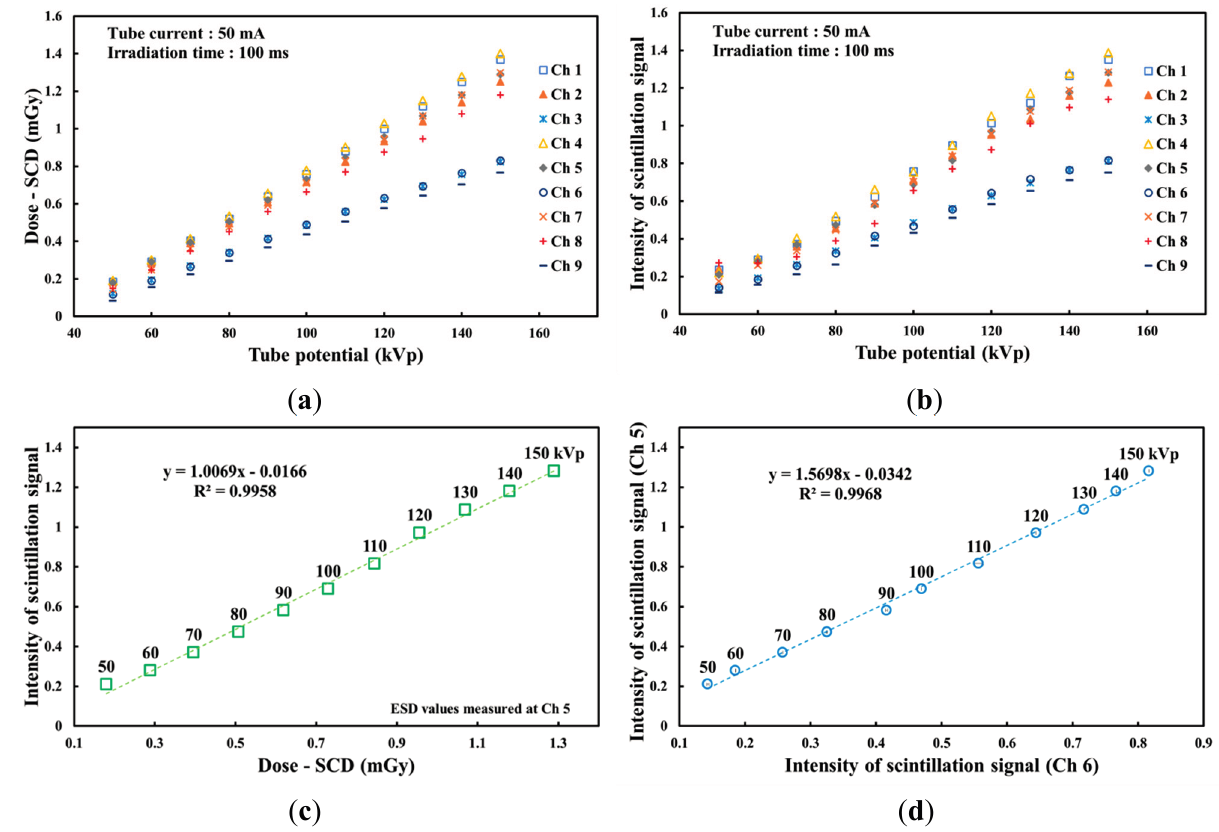
Figure 5. Variations of ( a ) the absorbed dose of the SCD and ( b ) the light intensity of the phantom dosimeter according to the tube potential. ( c ) Relationship between the light intensities of the phantom dosimeter and the ESDs of the SCD at Ch. 5 and ( d ) the correlation between two probes of the phantom dosimeter at each measuring point as a function of the tube